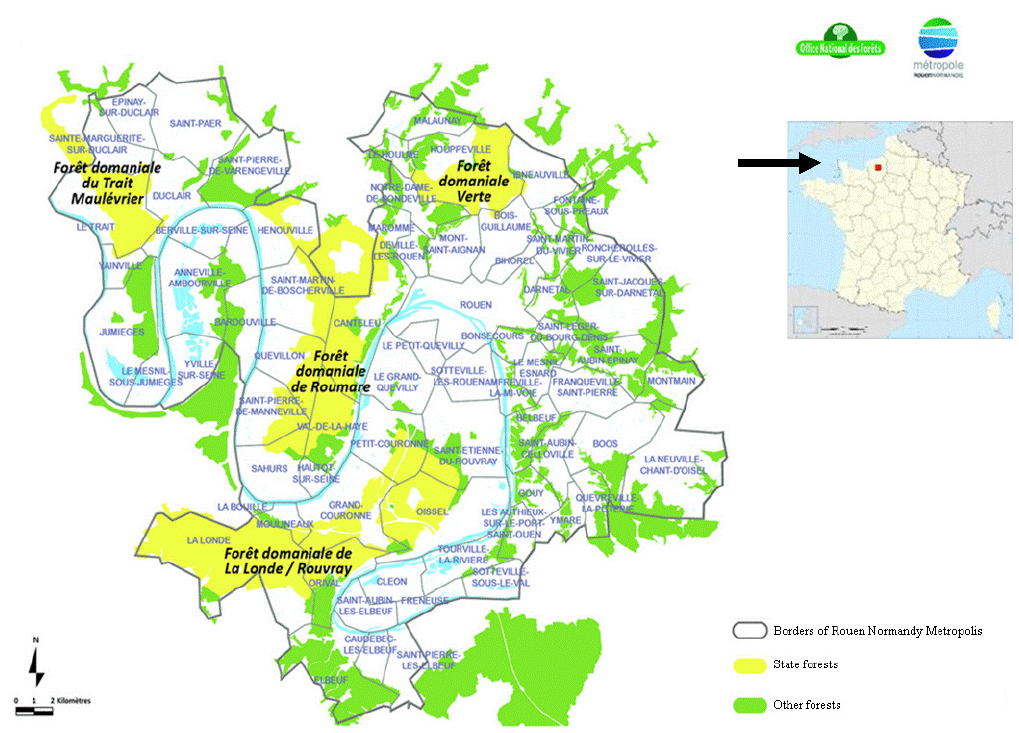
Figure 1. Forests of the RNM and its 71 municipalities. Source: Map by the Deputy Environment Directorate, taken from the RNM (n.d.) website and adapted by the